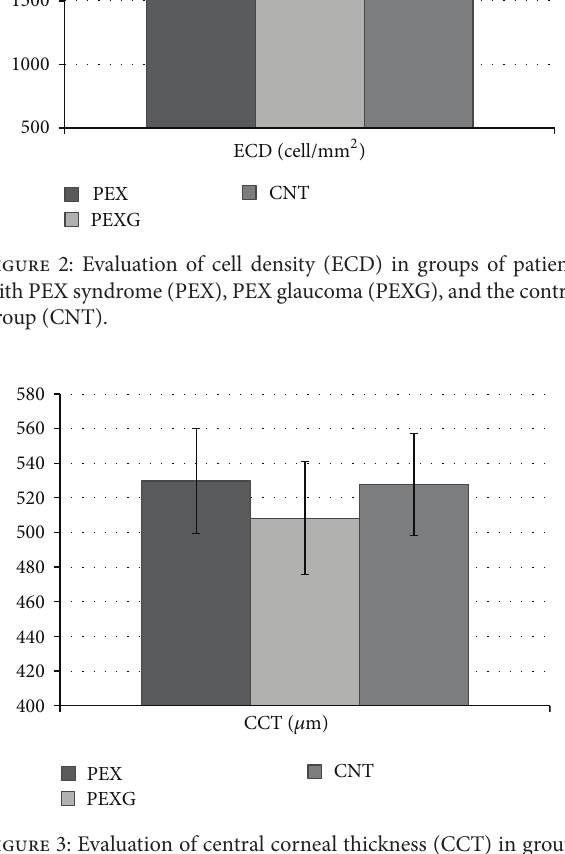
Figure 3: Evaluation of central corneal thickness (CCT) in groups of patients with PEX syndrome (PEX), PEX glaucoma (PEXG), and the control group